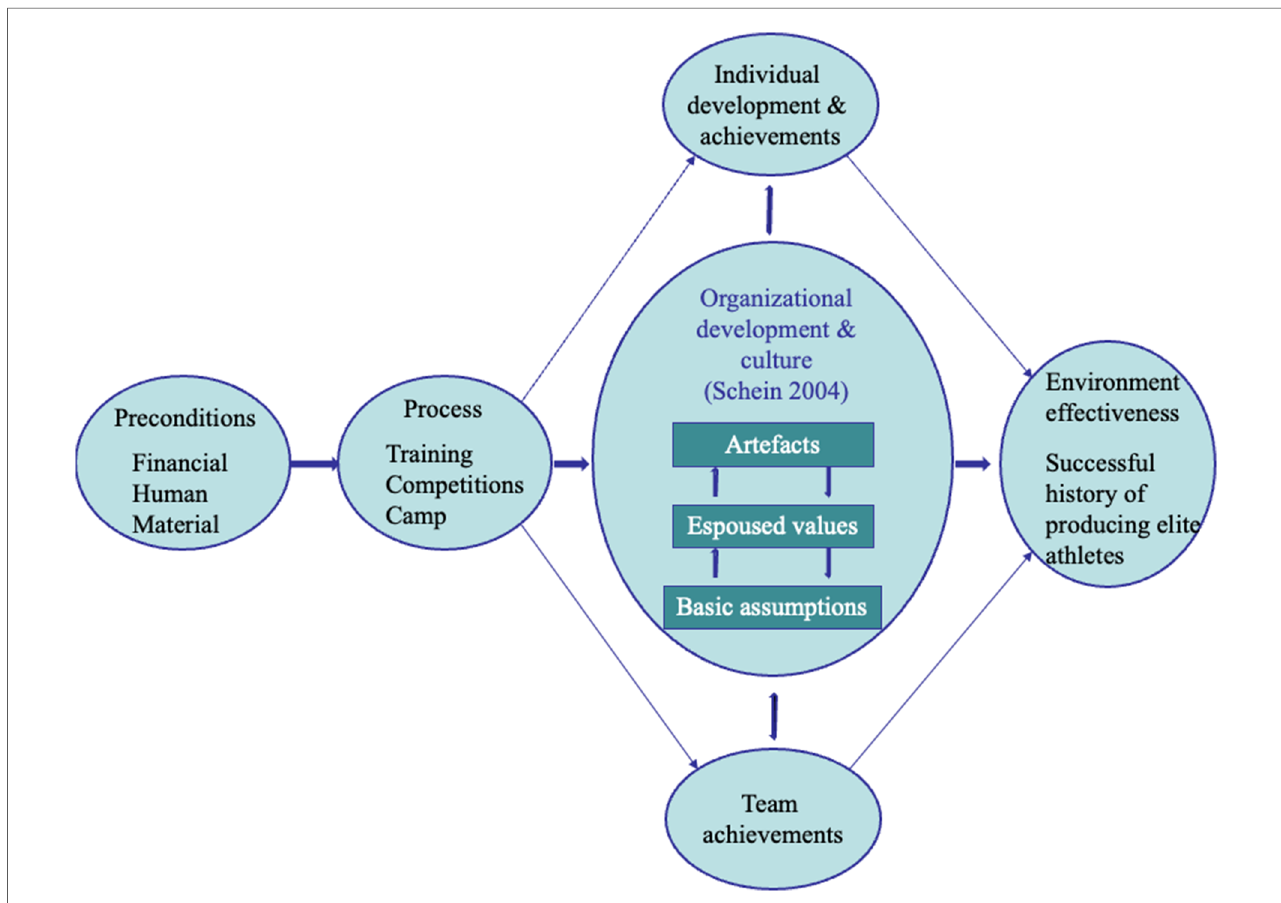
FIGURE 2 The environment success factors (ESF) working model. Reprinted with